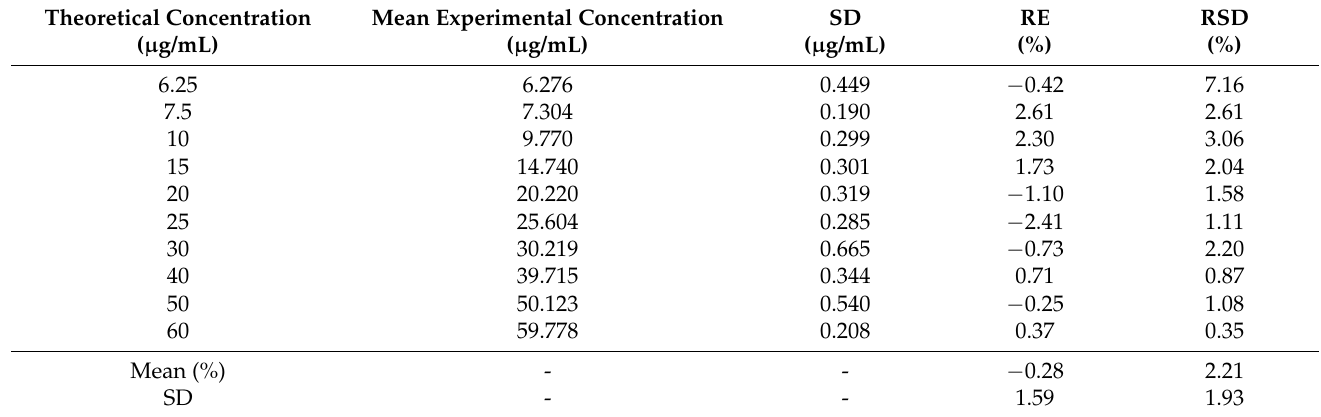
Table 7. Accuracy and intermediate precision of the spectrophotometric method.